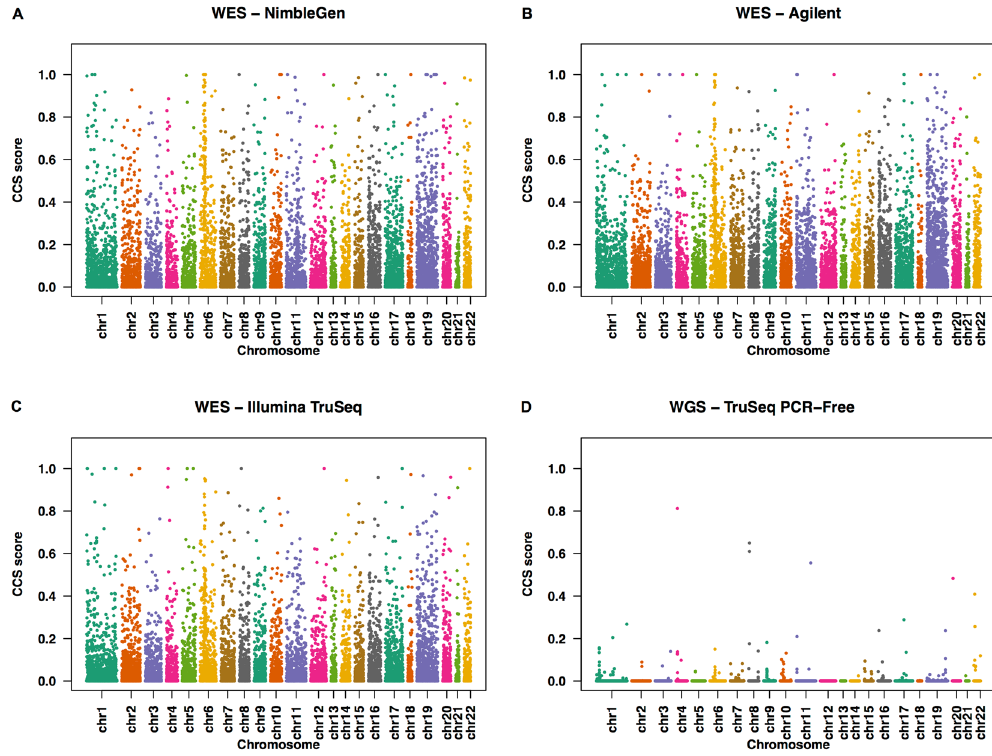
Figure 1. CCS scores of targeted RefSeq genes along the whole chromosome in WES and WGS datasets. The CCS values are plotted along the length of each chromosome in a modified Manhattan Plot for WES datasets